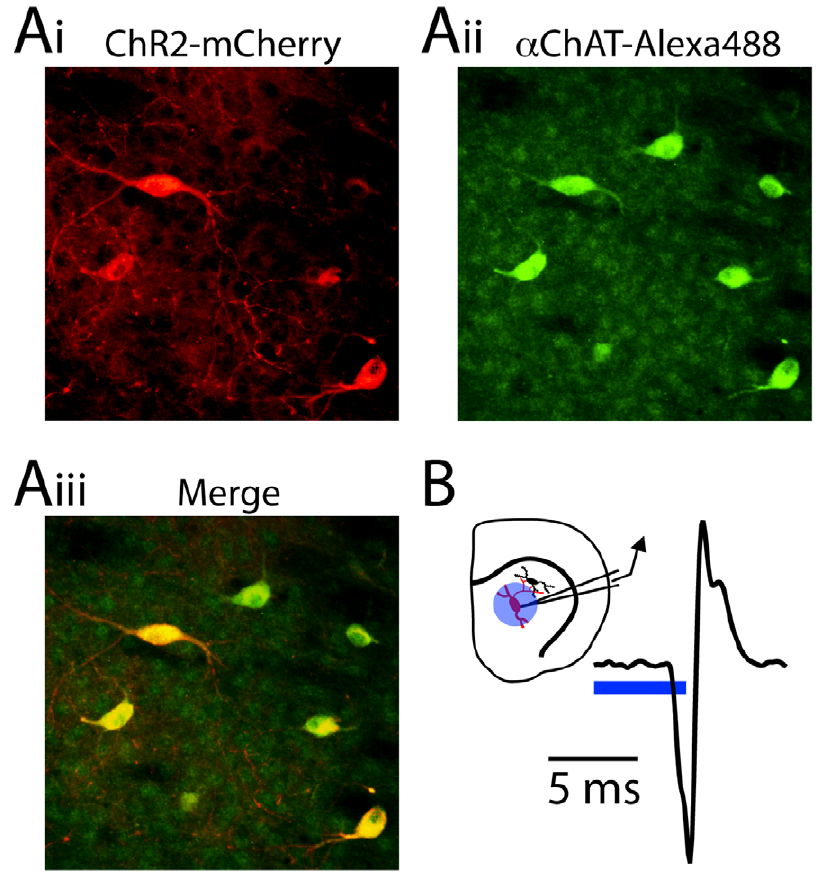
Figure 1. ChR2-mediated activation of striatal cholinergic interneurons. (Ai) Confocal image of mCherry-positive ChR2-expressing neurons in the dorsal striatum of a ChAT-IRES-Cre mouse injected with AAV encoding DFI-ChR2-mCherry. (Aii) Fluorescence immunohistochemical staining for ChAT reveals cholinergic neurons. (Aiii) Merged image. (B) inset, Schematic diagram of the recording conditions: cell-attached recordings were made from ChR2-expressing CINs (red) in the dorsal striatum and blue light was delivered to the surrounding area (blue circle) through the microscope objective. main panel, Example action potential recorded in cell-attached mode from a ChR2-expressing CIN evoked by a 4 ms pulse of 473 nm light.